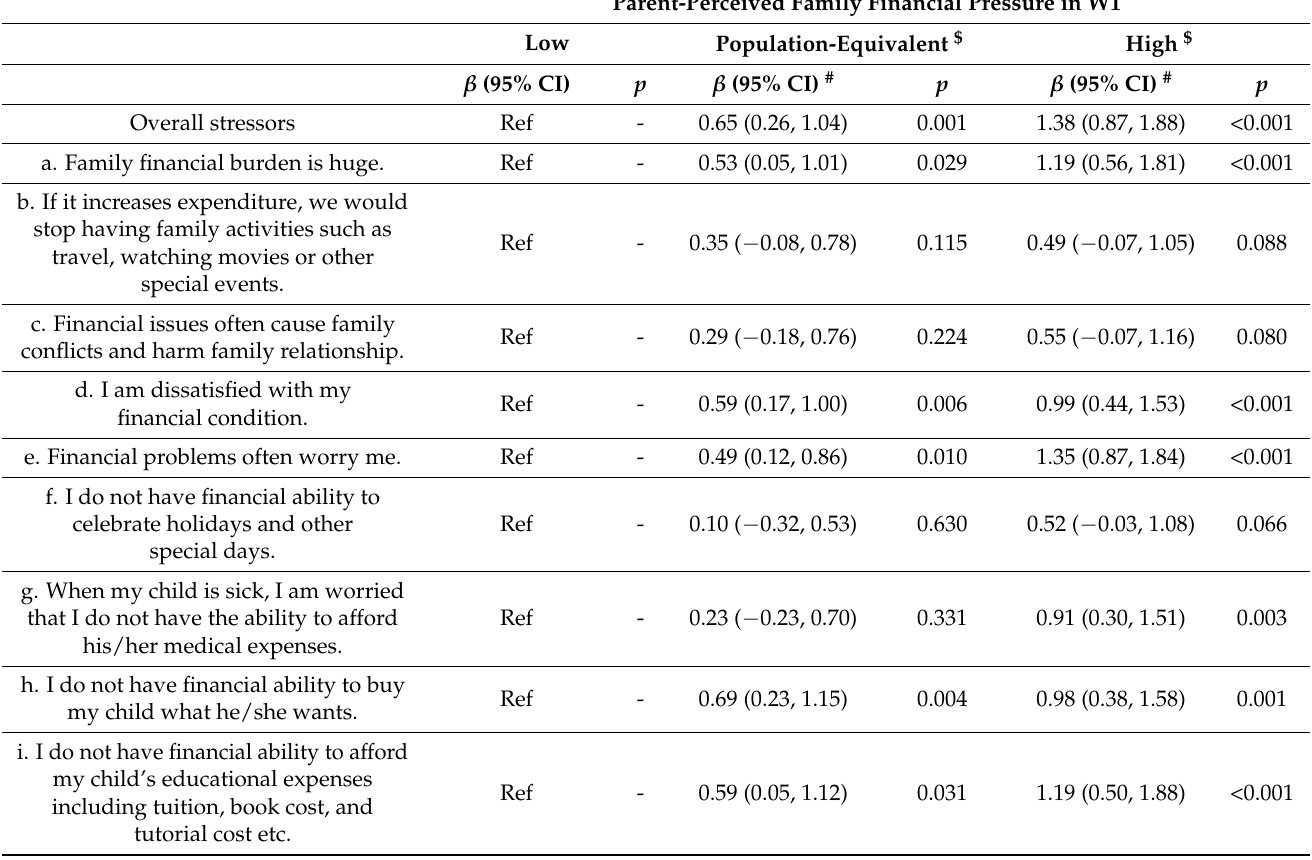
Table 2. Associations between parent-perceived family financial pressure and their level of agreement on